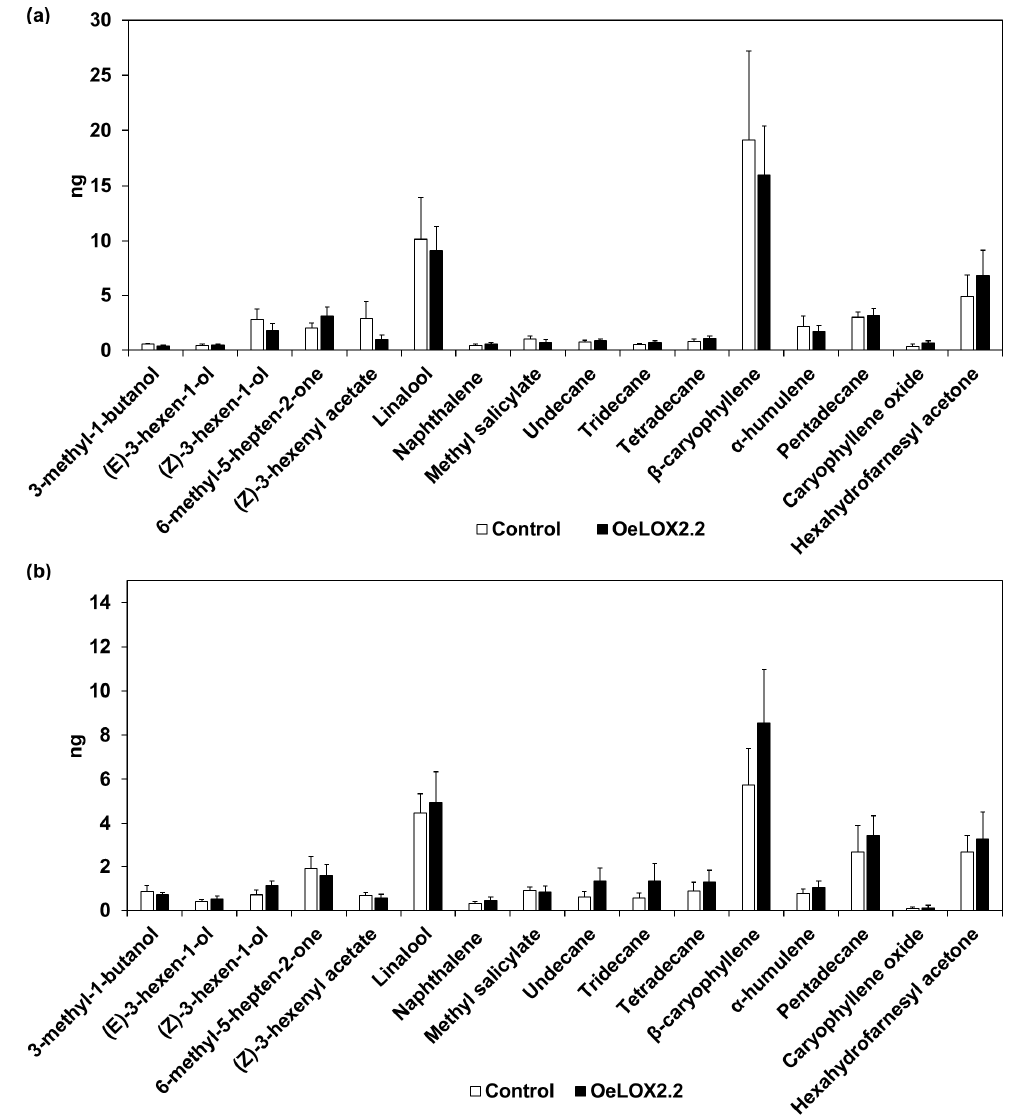
Figure 2. Volatile profiles of control and OeLOX2.2 lines. ( a ) Uninfested plants, ( b ) bird cherry-oat aphid (BCA)-infested plants. White bars represent the control plants and black bars the overexpressing line OeLOX2.2. Average amounts in ng (±SE) in 48 h volatile collection from 15 plants ( n = 6). 2.3. Bird Cherry-Oat Aphid (BCA) and Green Peach Aphid (GPA) Settling, Fecundity, and Lifespan on